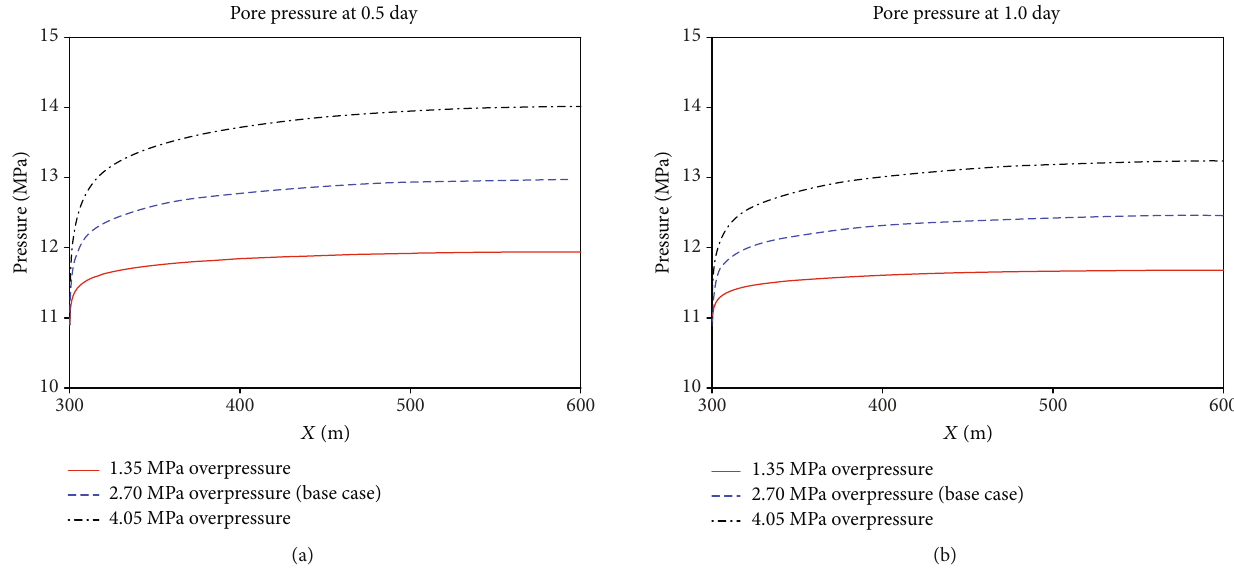
Figure 6: 1D pressure distribution from the wellbore to the domain boundary along Y = 300 m after (a) 0.5 day and (b) 1 day of shallow water fl ow for overpressure sensitivity.